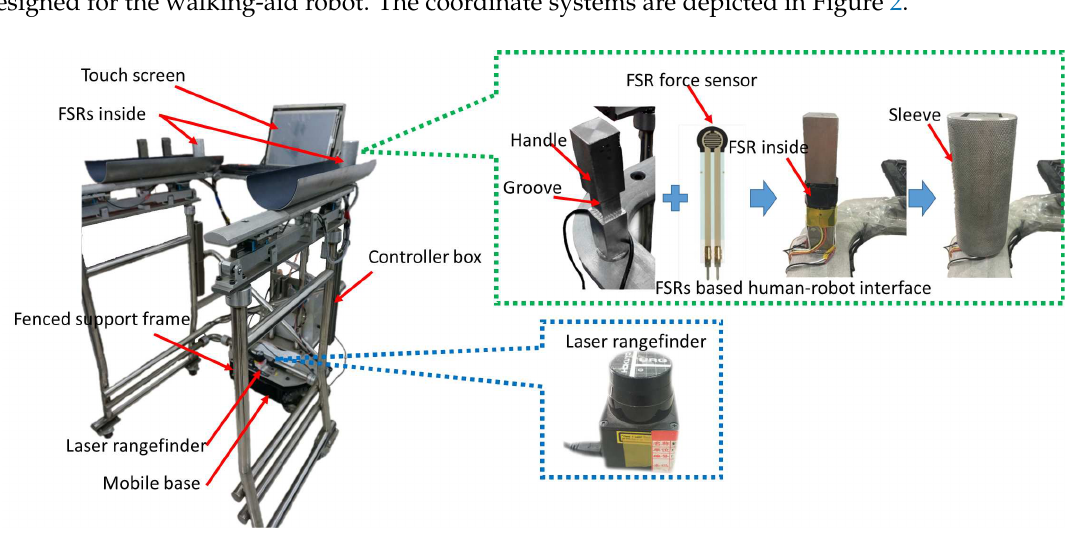
Figure 1. The walking-aid robot.